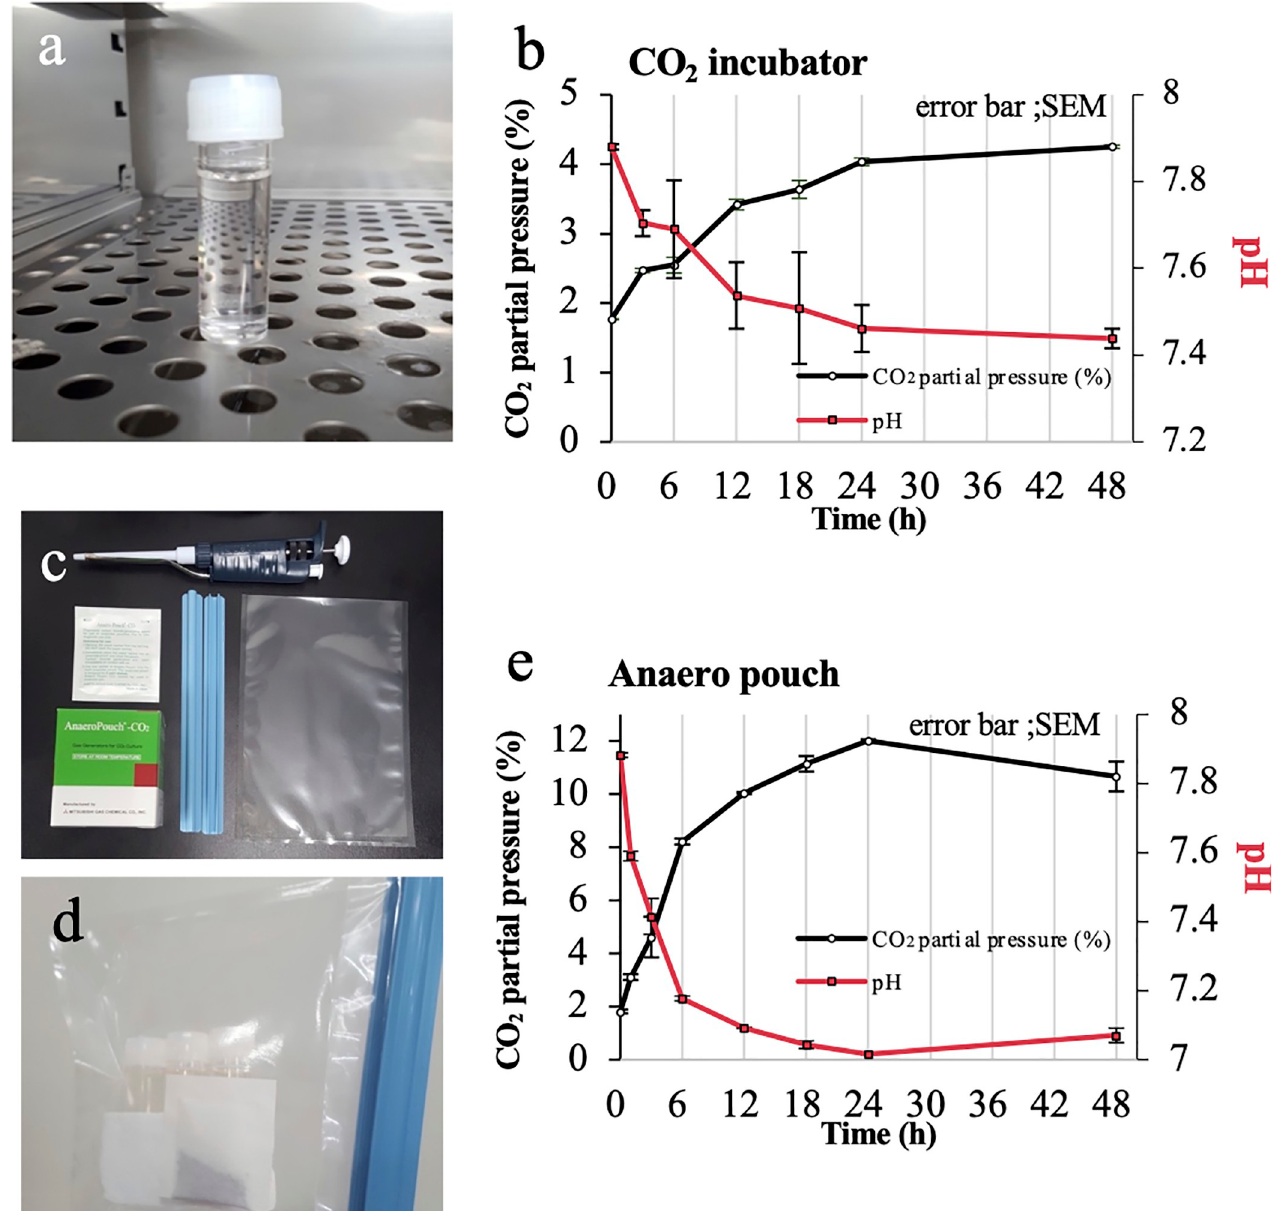
Fig 1. Change of CO 2 partial pressure and pH of the CZB medium. (a) A plastic tube containing 5 mL of CZB medium with a loose lid was placed in a CO 2 incubator. (b) CO 2 partial pressure and pH of the medium were measured up to 48 h using a CO 2 incubator. (c) An Anaero pouch, clips and gas barrier film. (d) An Anaero pouch with 5 mL of CZB medium in a barrier film. (e) CO 2 partial pressure and pH of the medium were measured up to 48 h using an Anaero pouch. Black line indicates partial pressure of CO 2 , and the red line indicates pH, with error bar (SEM).